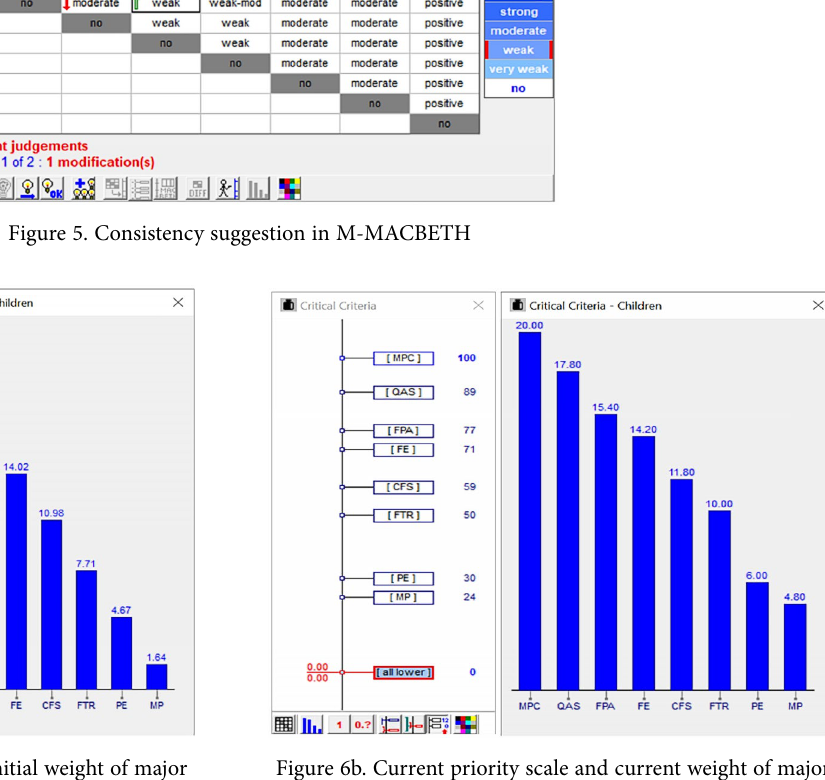
Figure 6a. Initial priority scale and initial weight of major criteria of critical criteria category